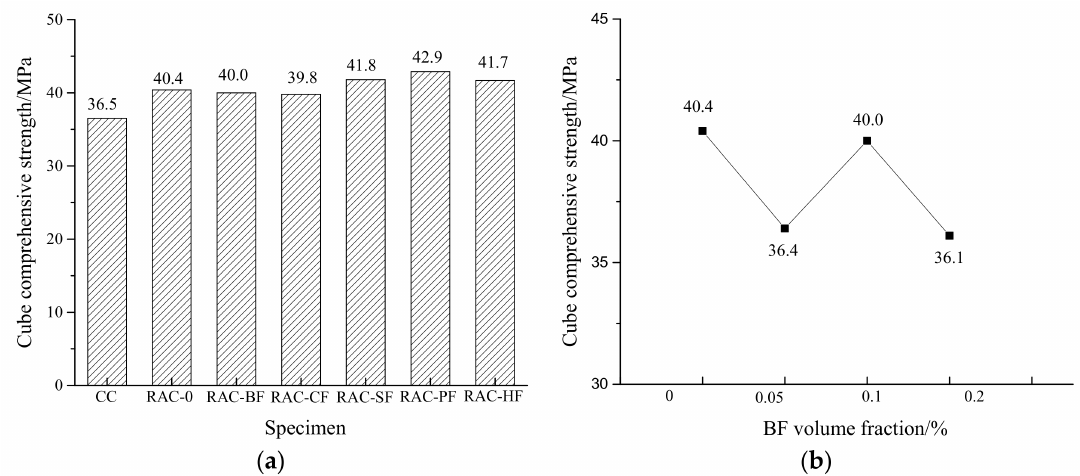
Figure 3. Changes in cube compressive strengths of RAC. ( a ) Different fiber-reinforced RAC; ( b ) Different BF-reinforced RAC.